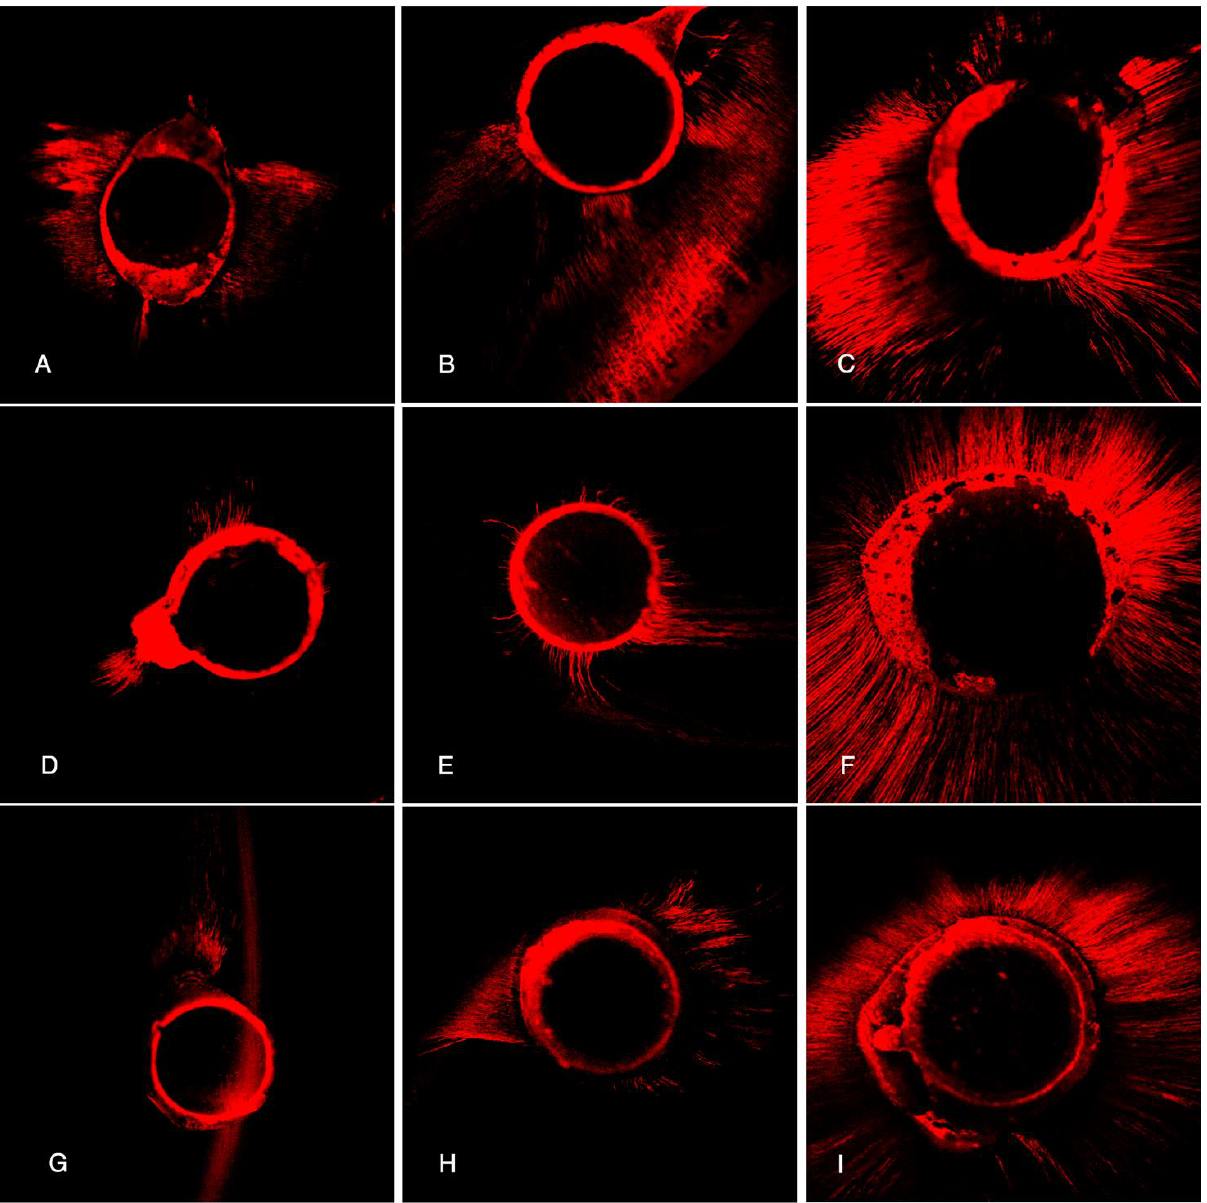
Figure 2. Representative CLSM images of each third for each of the studied sealers (10 × magnification). EndosSequence: apical ( A ), middle ( B ), and coronal ( C ) thirds; AH Plus: apical ( D ), middle ( E ), and coronal ( F ) thirds; BioRoot: apical ( G ), middle ( H ), and coronal ( I ) thirds.